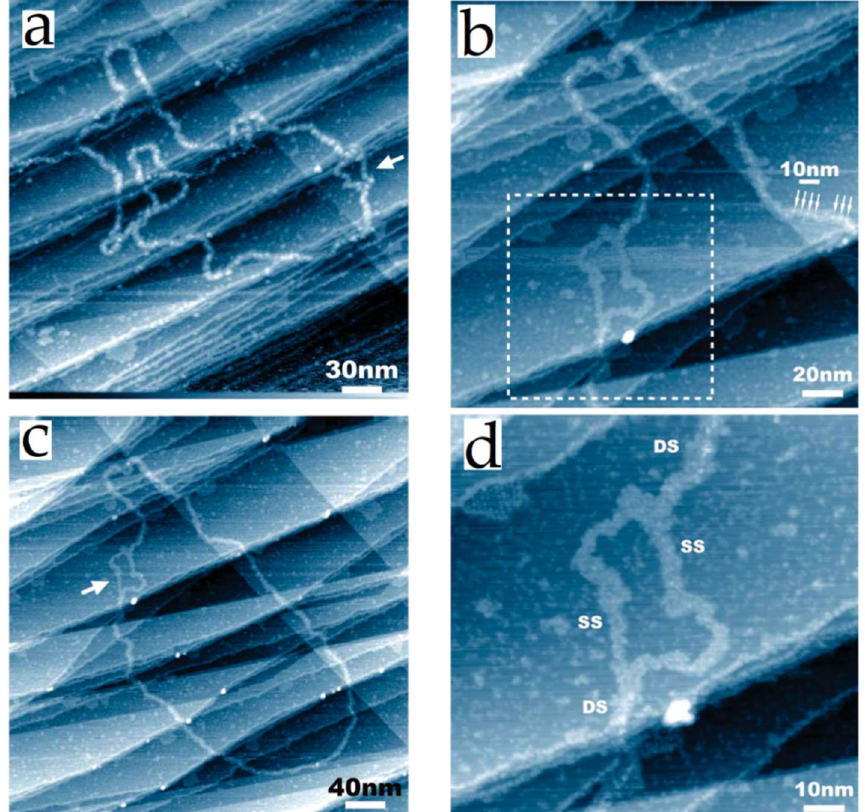
Figure 3. STM images of 2871 base-paired plasmid DNA were deposited on a Cu (111) surface using a pulse injection method. Typical STM images of plasmids ( a , c ). A higher magnification image of the area indicated with a white arrow in ( c ) is shown in ( b ). The white dotted square region of ( b ) shows a bubble-like structure, where single strands are indicated as SS, and double-stranded segments are indicated as DS ( d ). Reprinted with permission from Ref. [48]. Copyright (2010), American Chemical Society.